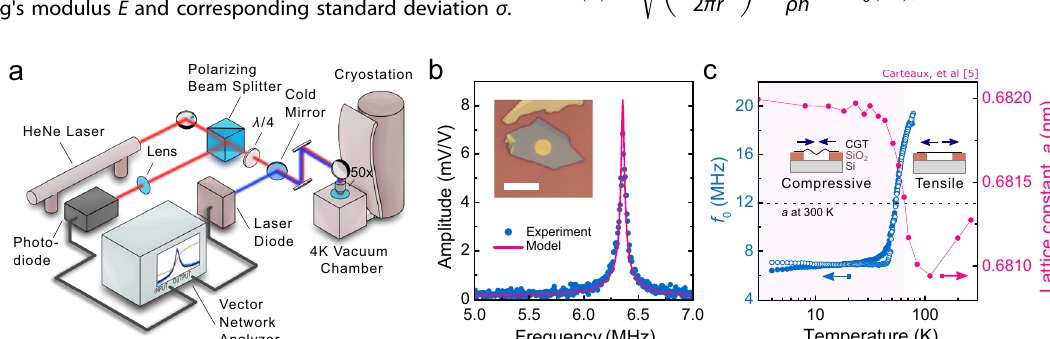
Fig. 1 Force indentation of suspended membranes of CGT. a An optical image of a 9.5 ± 0.3 nm thin CGT membrane with a radius r = 2 μ m. Scale bar: 12 μ m. b A schematic of the membrane de fl ection by a cantilever tip. Δ z c is the cantilever de fl ection, g 0 = 285 nm the separation between the membrane and the bottom Si substrate, d the membrane diameter, and δ the membrane de fl ection. c A force versus membrane de fl ection plot of the membrane shown in ( a ). Experimental data ( fi lled blue circles) are fi t by the point-force de fl ection of a circular membrane model of Eq. (1) (solid magenta line). The inset shows a histogram of the Young's moduli extracted from 18 CGT membranes of 9.5 – 30.1 nm thicknesses (see Supplementary Note 1), which were used to obtain the mean value of the Young's modulus E and corresponding standard deviation σ .